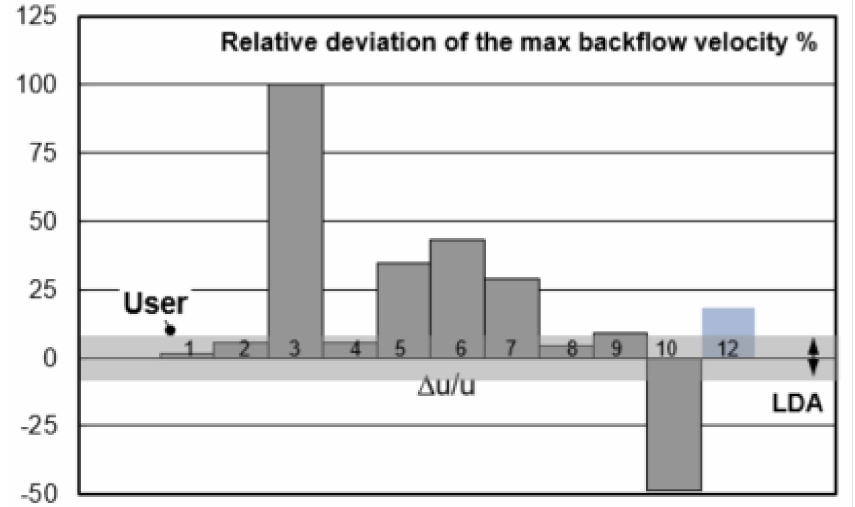
Figure 16. Relative deviation ∆ u/u of the maximum backflow velocity between CFD models among